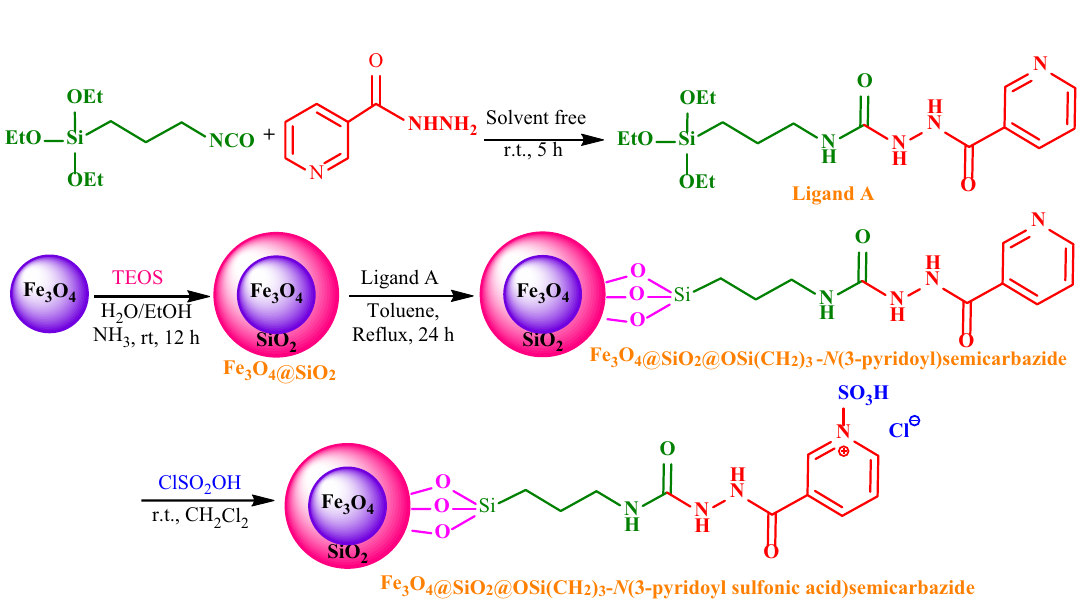
Figure 2. Synthesis of the FSiPSS